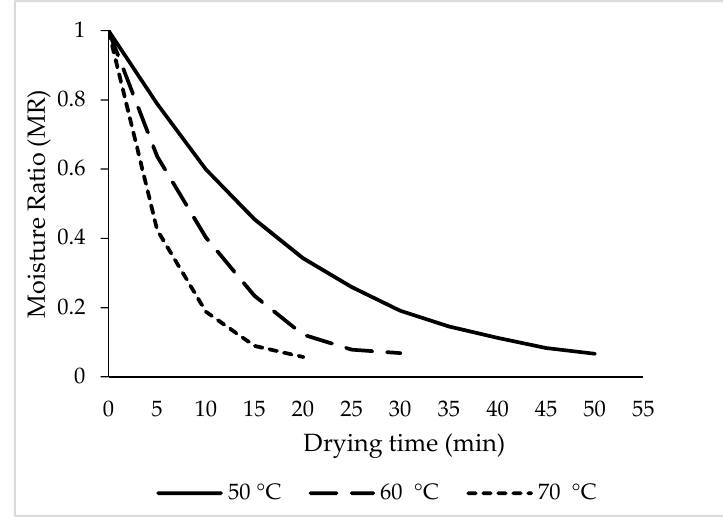
Figure 4. Moisture ratio changes at different air temperatures.